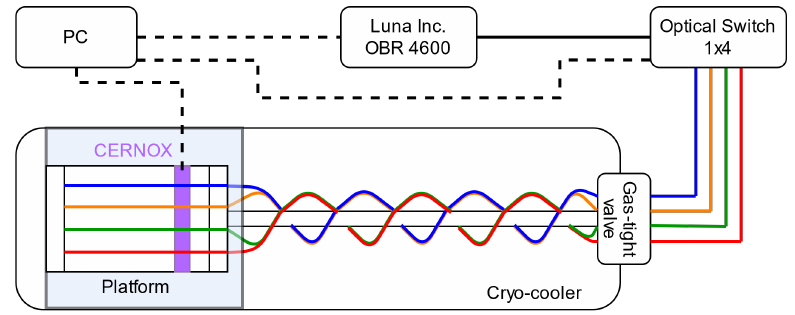
Figure 2. Schematic representation of the setup. Dashed lines represent electrical connections, the colored lines represent different fiber samples, namely blue, red, green and orange for Acrylate250, Acrylate400, Polyimide155 and PEEK400, respectively. The fibers in the platform were monitored through an optical switch connected to the Luna Inc. OBR 4600. A PC synchronized the OBR, the optical switch and the readings of the CERNOX inside the variable temperature